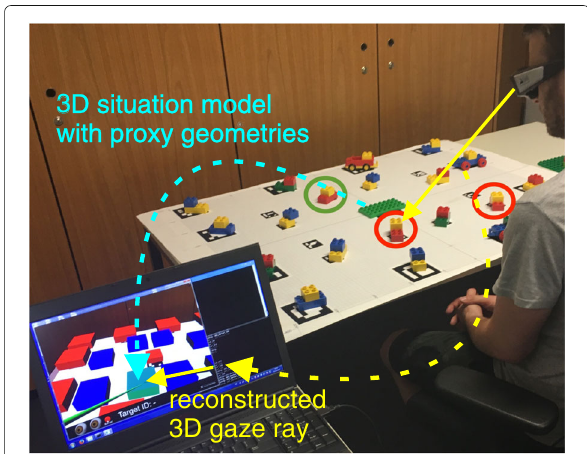
Fig. 1 Initial setup. The listener is seated in front of the workspace before any objects have been collected. The picture shows a green circle around the target and red circles around competitors. The listener currently inspects the competitor object to the left as highlighted in the virtual 3D model. EyeSee3D is used to reconstruct the gaze ray in 3D (yellow). The target domain is modeled as a 3D situation model with boxes as proxies for the assembled structures (turquoise)